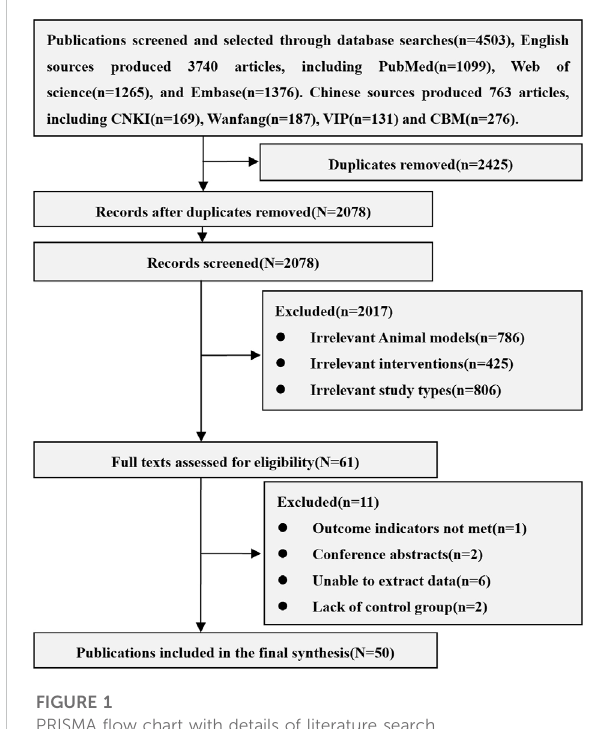
FIGURE 1 PRISMA fl ow chart with details of literature